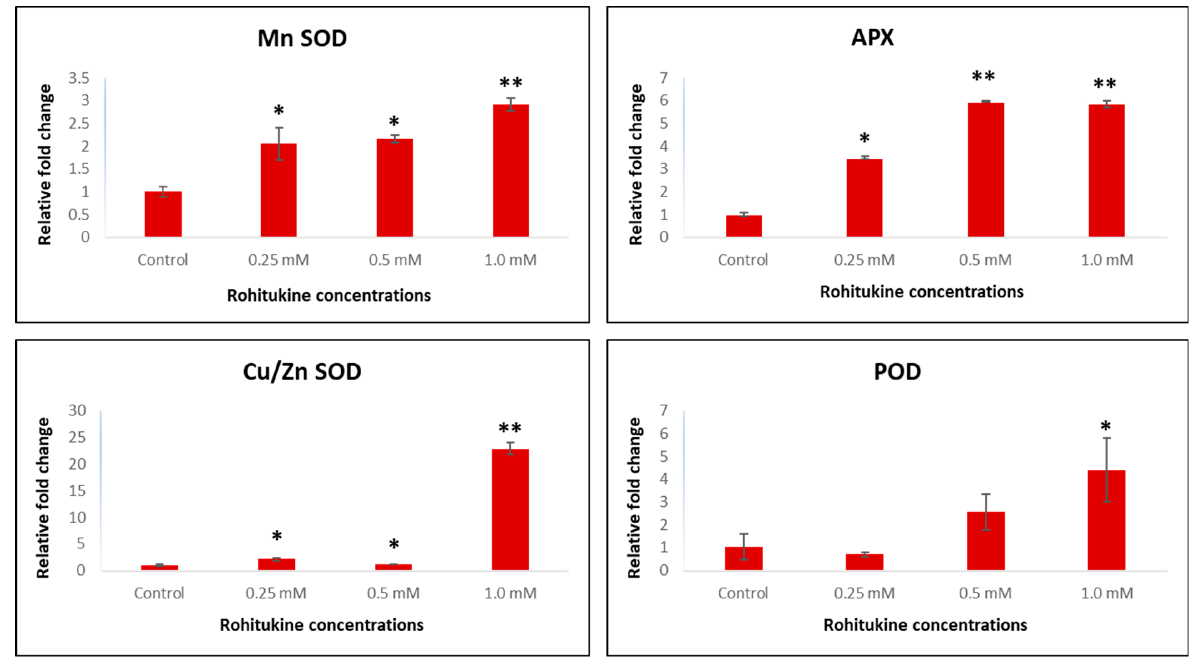
Figure 7. qRT-PCR-based expression analysis of key genes of the antioxidant system of A. thaliana . The bar diagrams represent the fold change expression of each gene upon 0.25 mM, 0.5 mM and 1 mM rohitukine exposure as compared to untreated controls. The results are presented as the means of three replicates and as means ± SDs. Statistical significance was determined by Student’s t -test. Asterisks * and ** denote the significance of fold changes at p -values < 0.05 and 0.005, respectively, as compared to untreated controls.